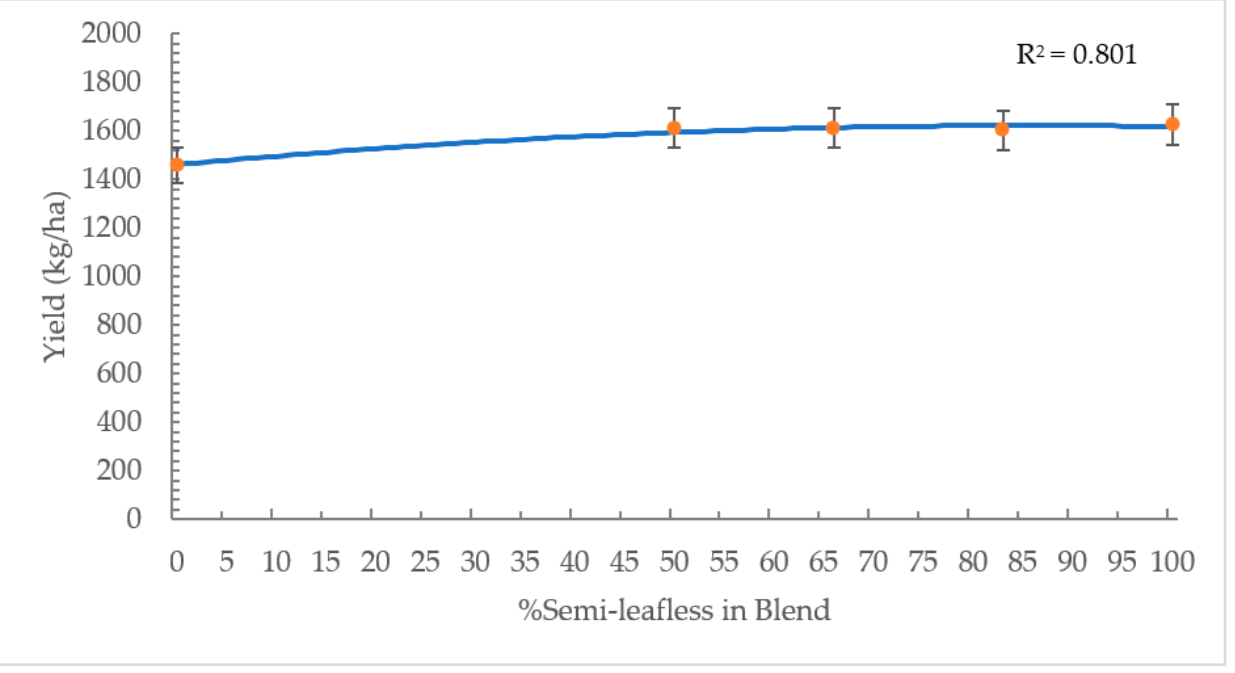
Figure 8. Regression of semi-leafless/leafed ratio on predicted yield based on the combined varieties. Mean of six site-years, one in 2017, two in 2018, and two in 2019.